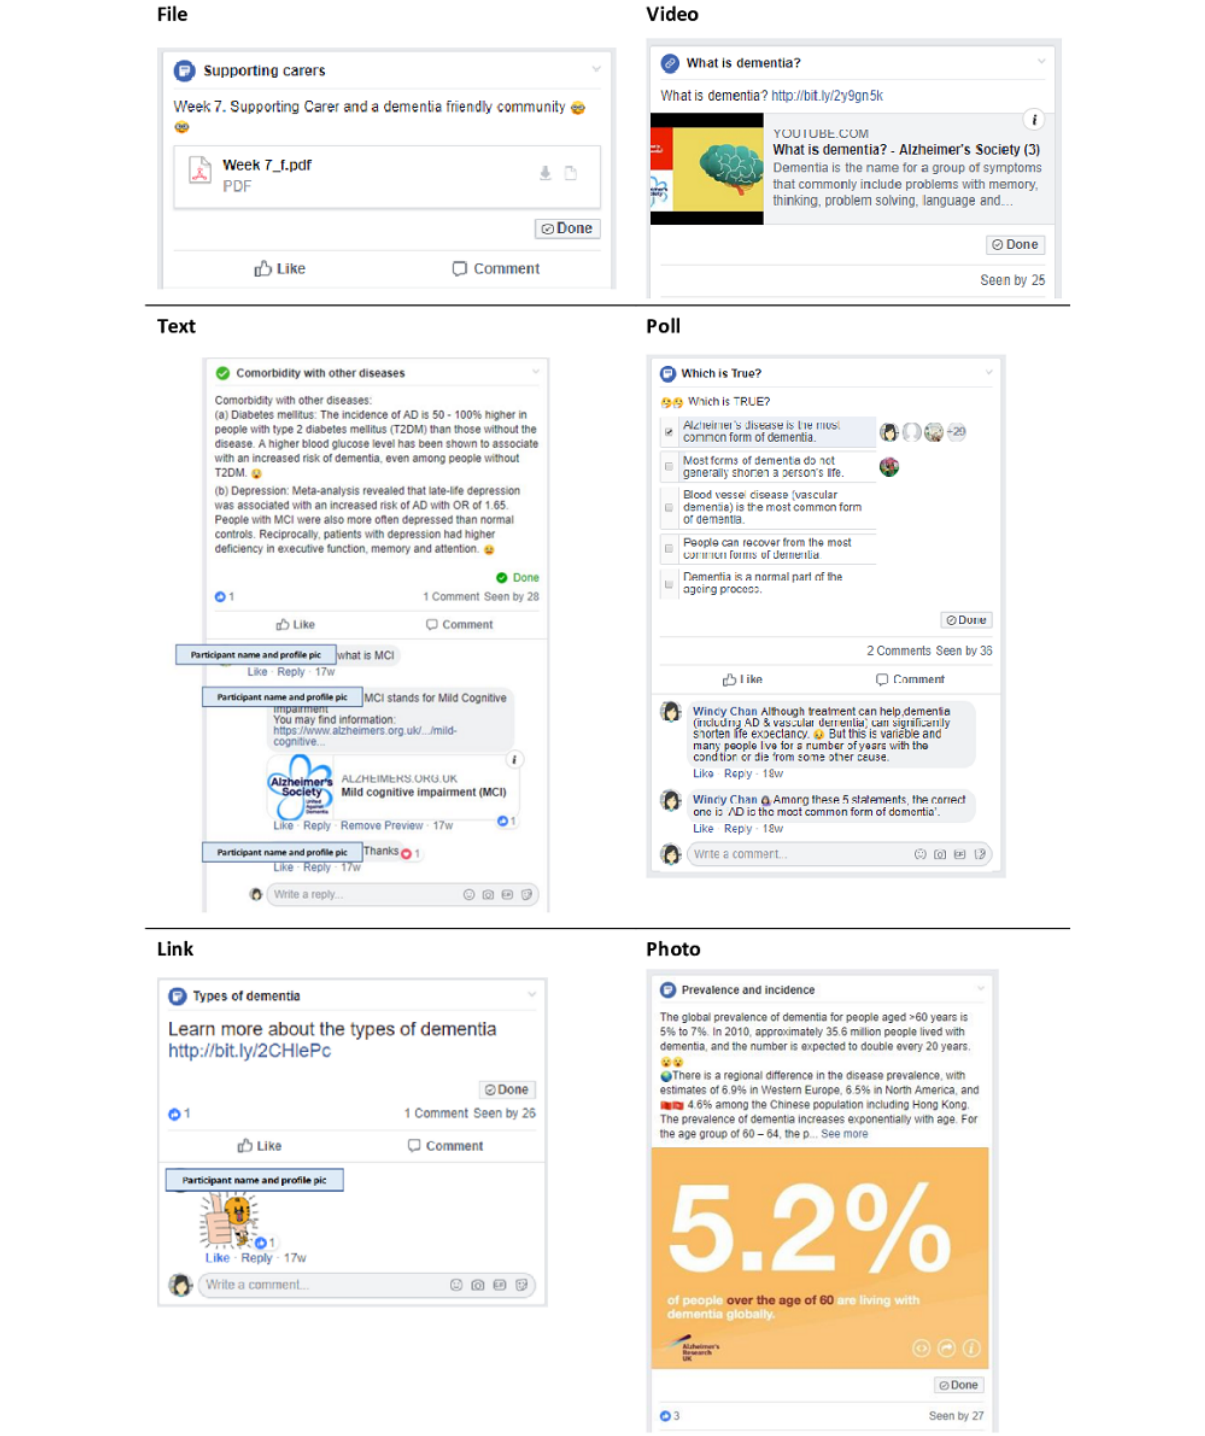
Figure 1. Representative screenshots of six types of Facebook